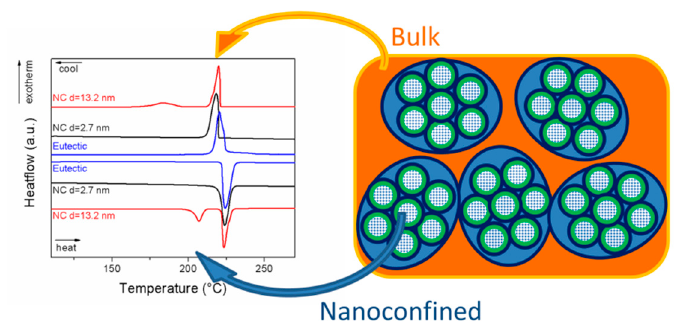
Figure 1. DSC data of molten salt eutectic and nanocomposites with mesoporous silica nanomaterials (MSN) with pore diameter of 2.7 and 13.2 nm ( left ), and schematic representation of salt distribution ( right